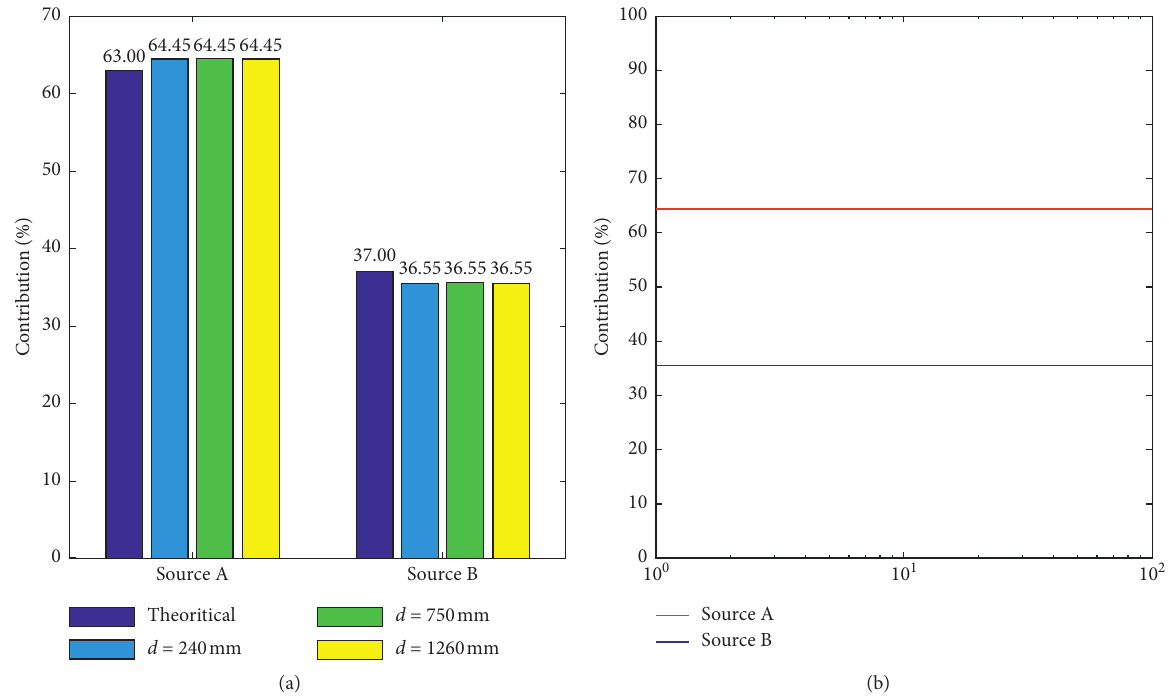
Figure 24: Contributions for different distances: (a) contribution per source; (b) contribution point by